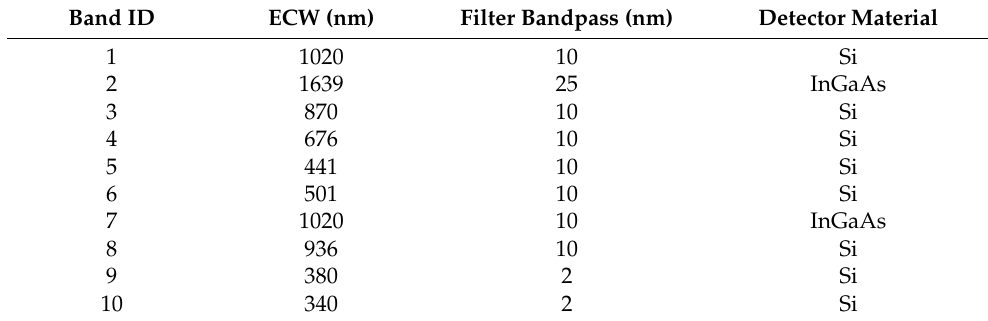
Table 1. The specific information of